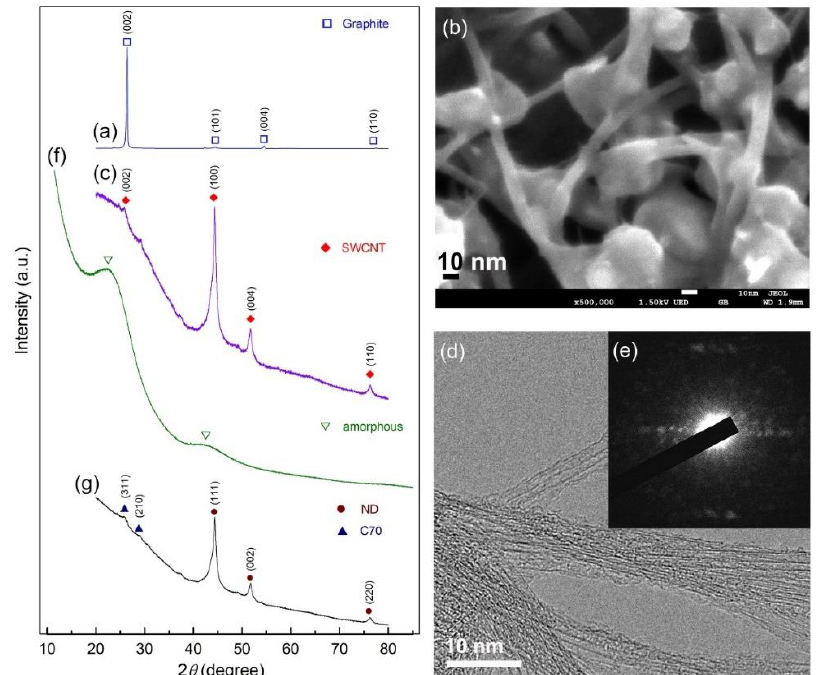
Figure 8. XRD diffraction patterns and FE-SEM images of the powders obtained after ball milling for ( a ) 0 h, and ( b ) 12 h, respectively. In ( c–e ), the XRD patterns and corresponding FE-HRTEM, NBDP of the sample obtained after 10 h are shown. The XRD patterns for the samples milled for 16 h and 28 h are displayed in ( f , g ), respectively. micrograph of graphite powders produced after 0 and 12 h of high energy ball milling, respectively.